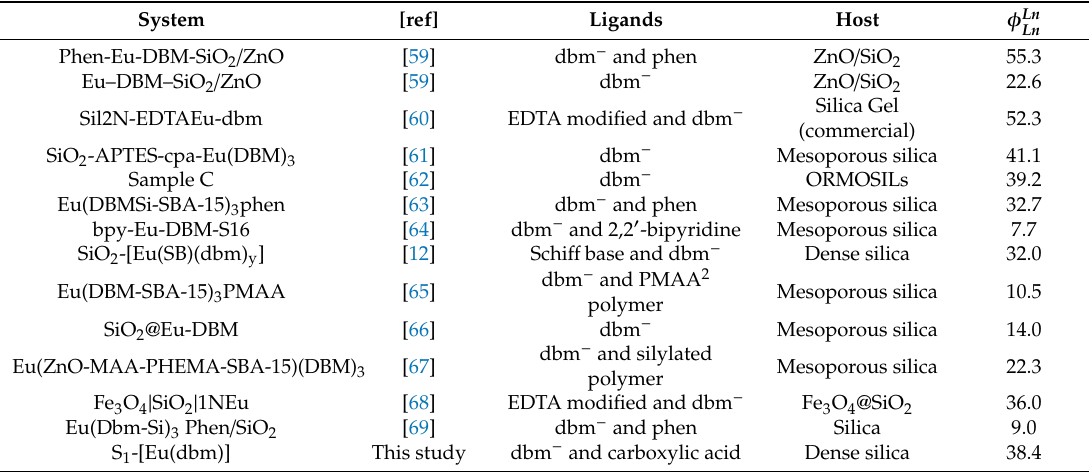
Table3. State-of-the-artofluminescenthybridscontainingdbm − ligandscoordinatedtoEu 3 + comparing φ Ln as a figure of Ln